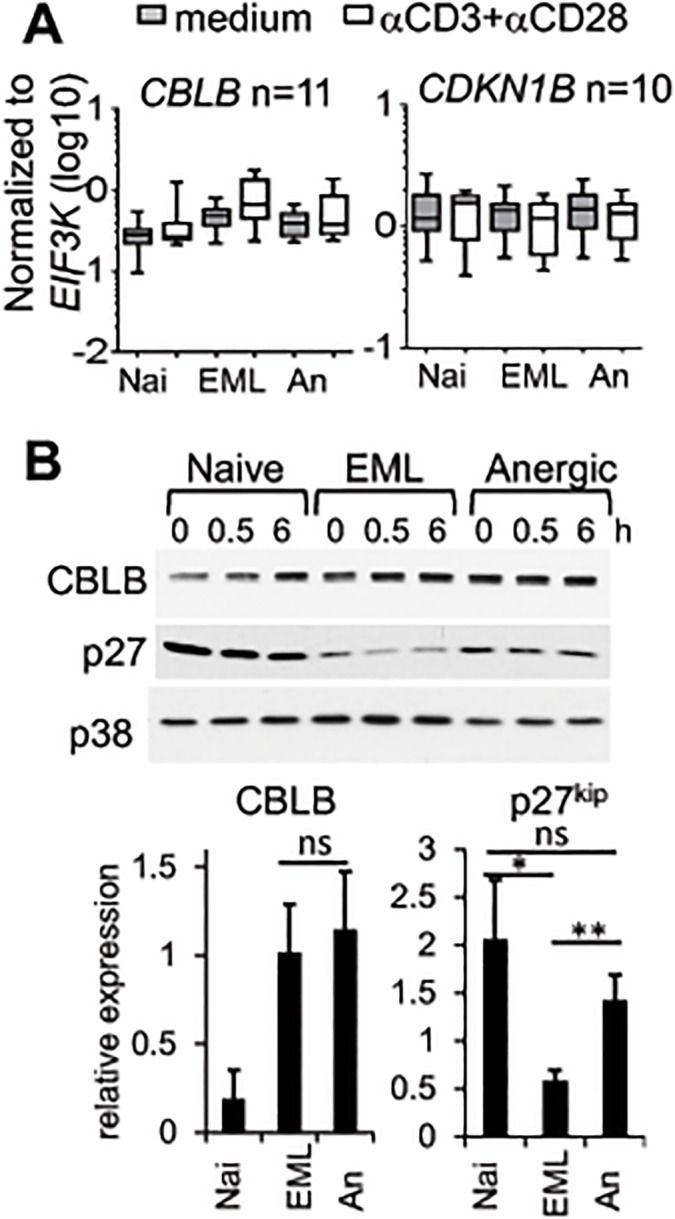
Human anergic cells have increased level of p27kip1.
A-B. Naïve, EML, and anergic cells were left untreated or stimulated with soluble αCD3 + αCD28, and A. mRNA level after 4 hours (Box and whiskers plot) or B. protein level of CBLB and p27kip1 after 0, 0.5, and 6 hours were measured. The lower panel represents the relative protein expression of CBLB and p27kip1 to p38 as loading control from 6 (CBLB) and 10 (p27kip1) independent experiments at 0 hours (*p<0.05, **p<0.01; ns, not significant). The data are presented as mean ± SEM. An, anergic cells; EML, effector/memory-like T cells; Nai, naïve cells.